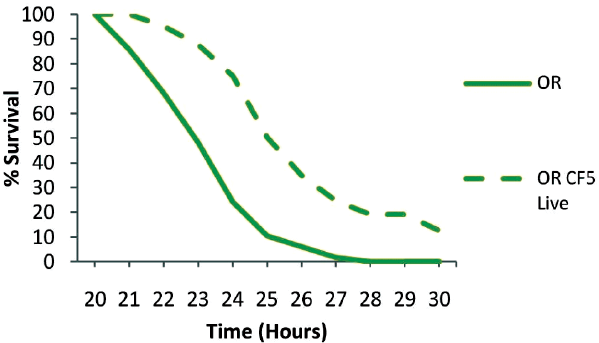
Figure 2. Survival kinetics of wt PA14 infected flies 11 days post priming with live Pseudomonas aeruginosa CF5. P. aeruginosa PA14 injection in primed (dashed line) and non primed (continuous line) Oregon R flies with live CF5 bacteria showed an extension in the 50% survival time for over of two hours in contrast to controls and more that 10% survived at 30 hours post infection (P<0.0001). n=40–49 flies per